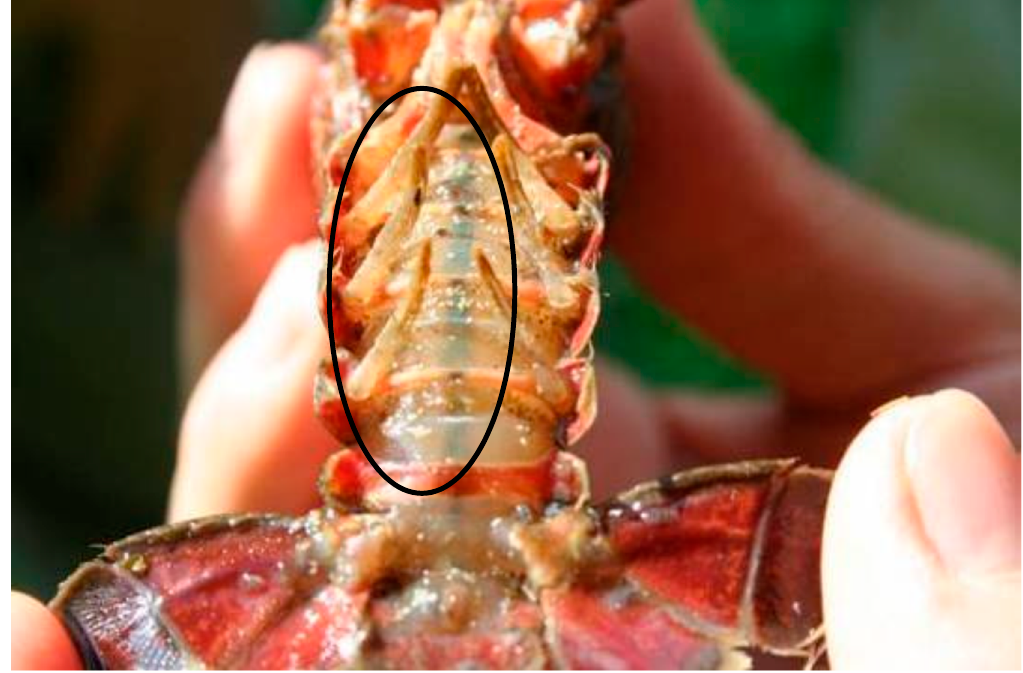
Figure 3. Individual alien temnocephalan crayfish ectoparasite Temnosewellia minor on a specimen of Procambarus clarkii .